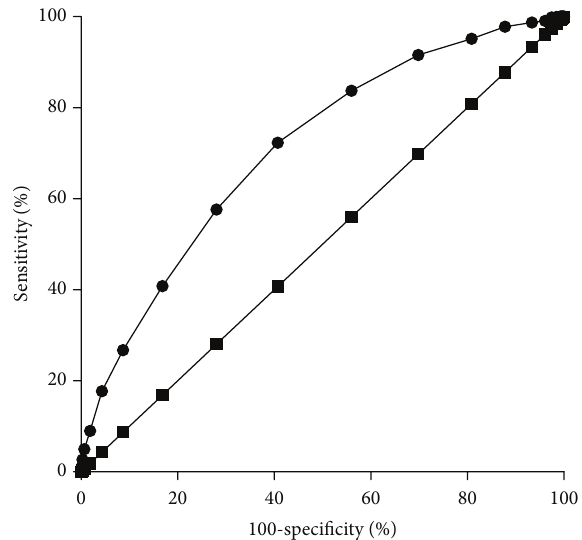
Figure1:ReceiveroperatingcharacteristiccurvefortheOSTscores. The area under the curve is 0.71 ( 𝑃 < 0.0001 ). The straight line is the line of identity, corresponding to an area under the curve of